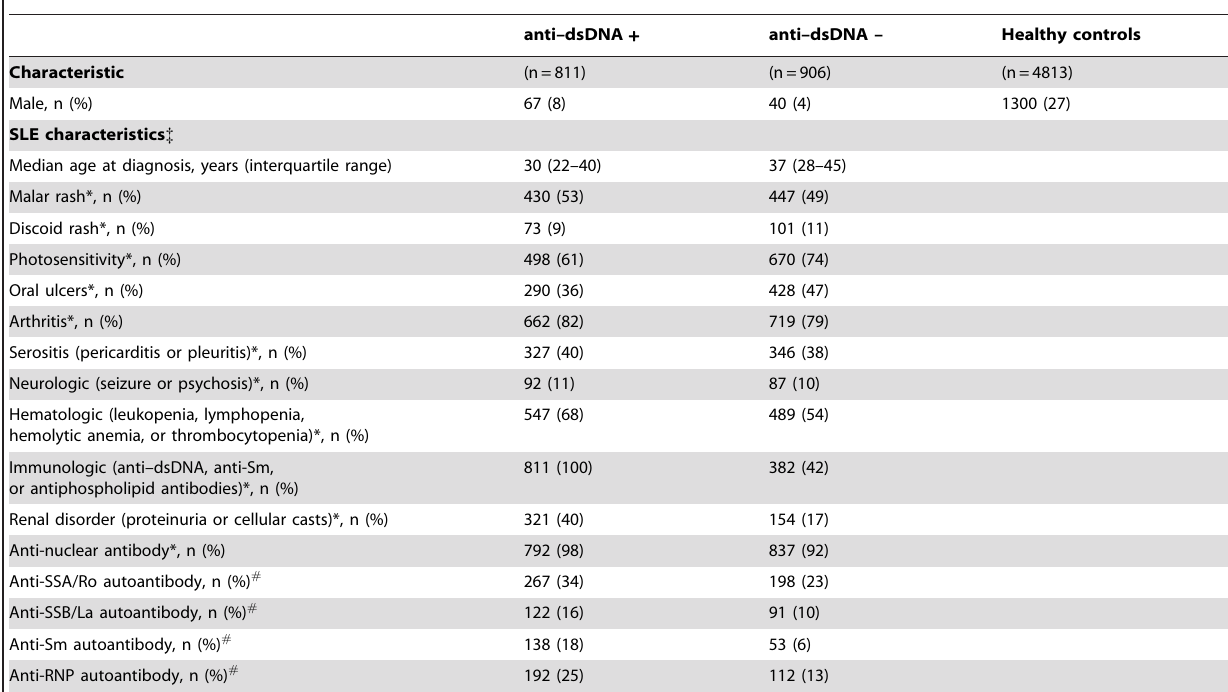
Table 1. Characteristics of the study